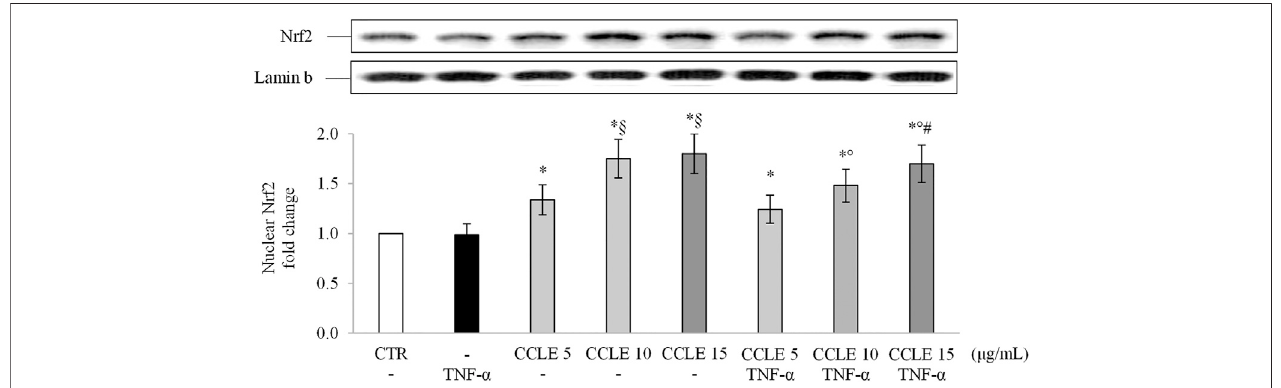
FIGURE5 | NuclearNrf2.The Caco-2 monolayer waspretreated with CCLE (5-15 μ g/ml) for 24 h, and subsequently exposed to 50 ng/ml TNF- α for 6 h. Cultures treated with the vehicles alone were used as controls (CTR). Caco-2 nuclear lysates were analysed by Western blot, and nuclear localization of the Nrf2 protein was evaluated. Nrf2 intensity values were normalized to the corresponding Lamin B value. Results are reported as fold change against CTR and expressed as mean ± SD of three independent experiments. * p < .05 vs CTR; ° p < .05 vs TNF- α ; § p < .05 vs CCLE 5 μ g/ml; # p < .05 vs CCLE 5 μ g/ml + TNF- α